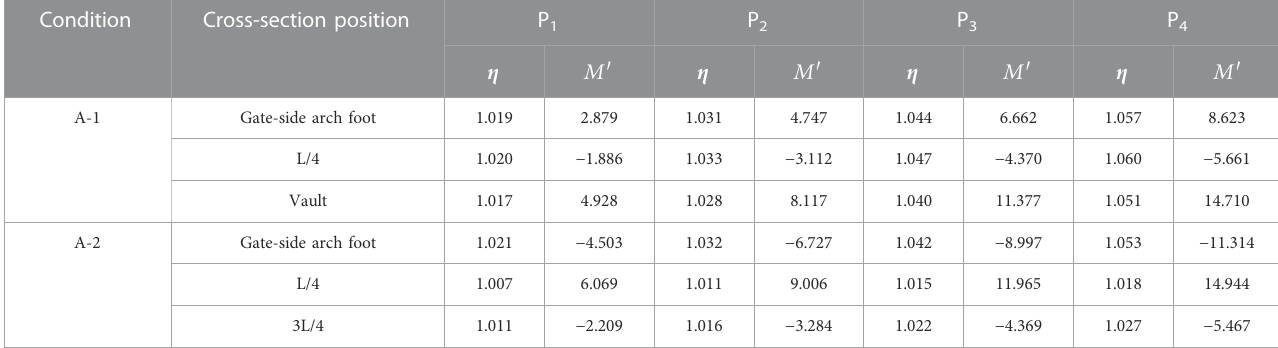
TABLE 8 Geometric non-linear bending moment values calculated by the regulation (unit: